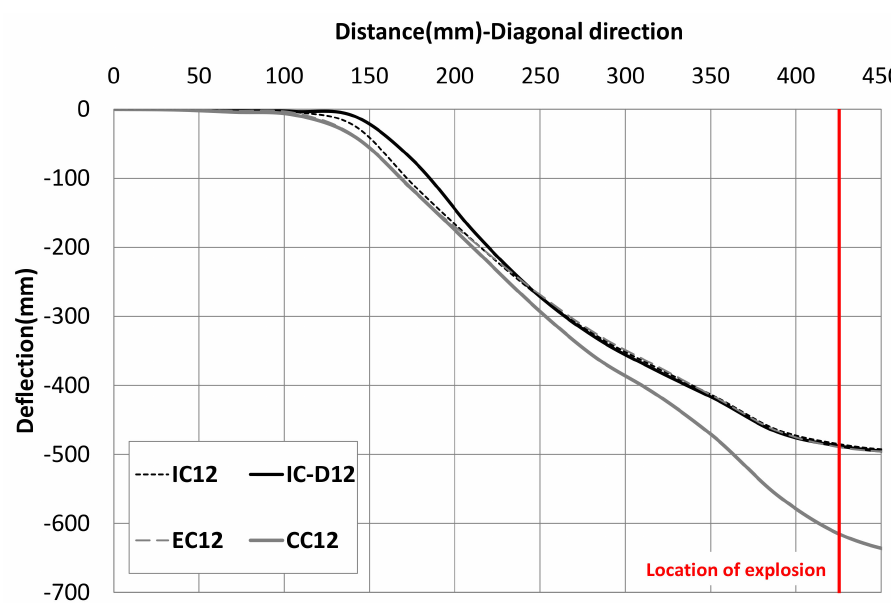
Figure 7. Slab deflection of specimens with TNT 12